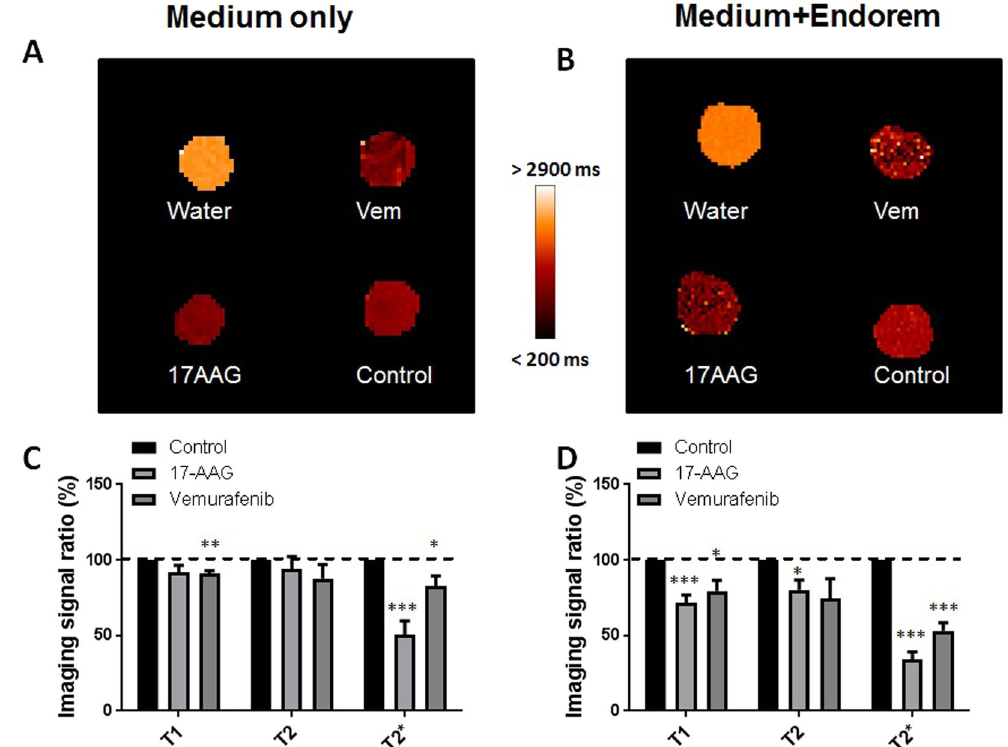
Figure 4. MRI relaxation time changes associated with melanin accumulation under BRAF and Hsp90 inhibition. ( A , B ) Show T 1 maps obtained from 4 eppendorf tubes containing water as an external control and 3 different SKMEL28 cell pellets: DMSO treated cells (Cont), cells under Hsp90 inhibition (17-AAG) and cells under BRAF inhibition (Vem). Cells were cultured in standard medium ( A ) or medium containing exogenous iron oxide (Endorem, 0.5 μ g/ml) ( B ), which enhanced differences in T 1 between treated and control pellets as relaxation times of treated cells with respect to shown in the maps. ( C , D ) Show the changes in T 1 , T 2 and ∗ T 2 control, cultured in standard medium ( C ) and medium containing Endorem ( D ). Both drug treatments induce a significant shortening in T 1 and ∗ T values, which is enhanced in cells cultured with Endorem. The error bars 2 represent standard error of the mean (n = 5). ( * p < 0.05, ** p < 0.01, *** p <